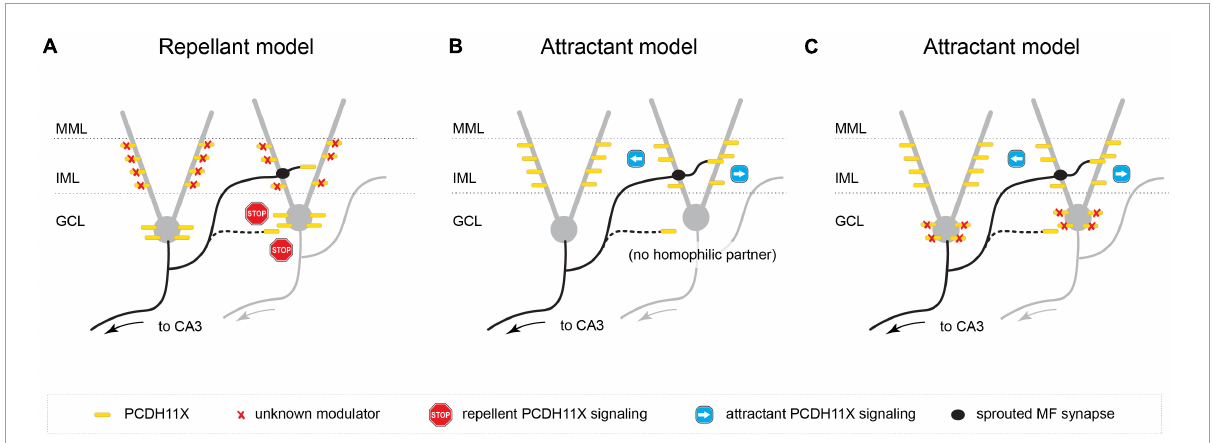
FIGURE8 Possible models for PCDH11X function in MF sprouting. (A) PCDH11X is surface-expressed on sprouting GC axons as well as in both the IML and GCL, and homophilic trans PCDH11X interactions serve as a repellant in both layers. This model requires a second unknown modulator that selectively negates repellant PCDH11x signaling in IML. (B) PCDH11X is an attractant and is surface displayed on sprouting GC axons as well as GC dendrites in IML. Homophilic PCDH11X interactions drive selective synapse targeting to the IML during sprouting. (C) PCDH11X is an attractant and is surface displayed on sprouting GCL axons as well as on somata and dendrites both in GCL and IML. This model requires a second unknown modulator that competes for binding with PCDH11X and outcompetes homophilic trans